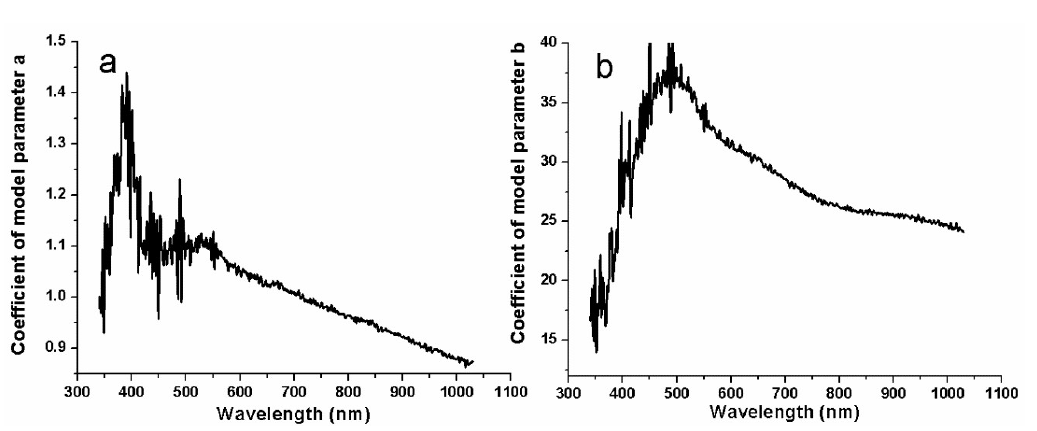
Figure 11. The changes of p -values for correlations of the spectral ratio of DSSR to MSSR with soil moisture content over wavelength.